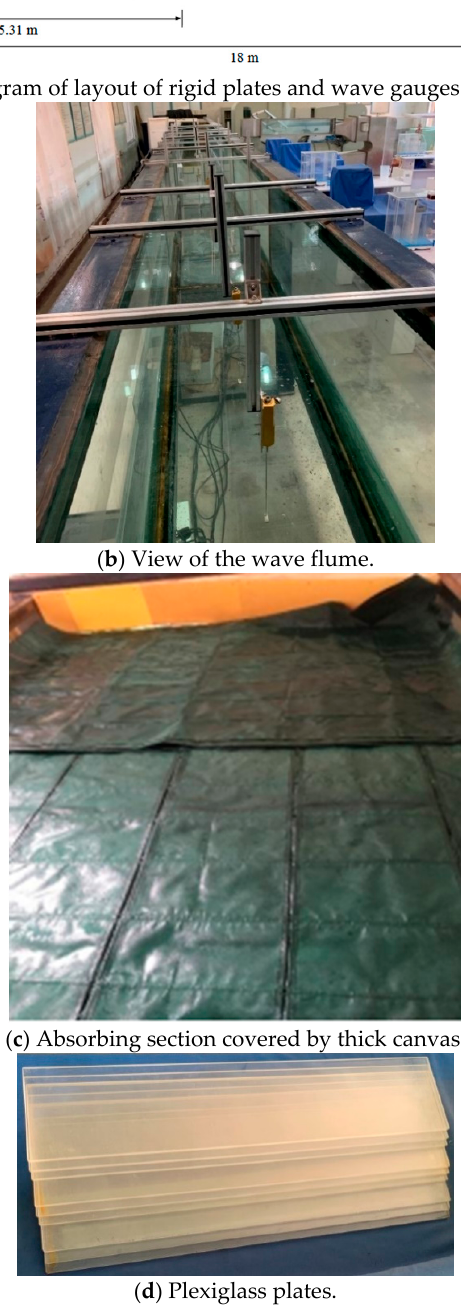
Figure 9. Experimental set-up of multiple vertical rigid plates.